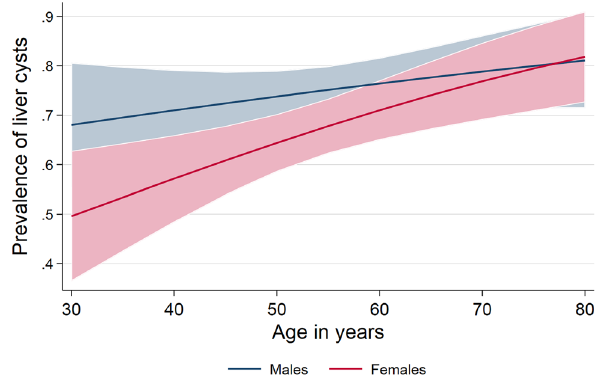
Figure 2. Association between age and cyst frequency for male and female volunteers.